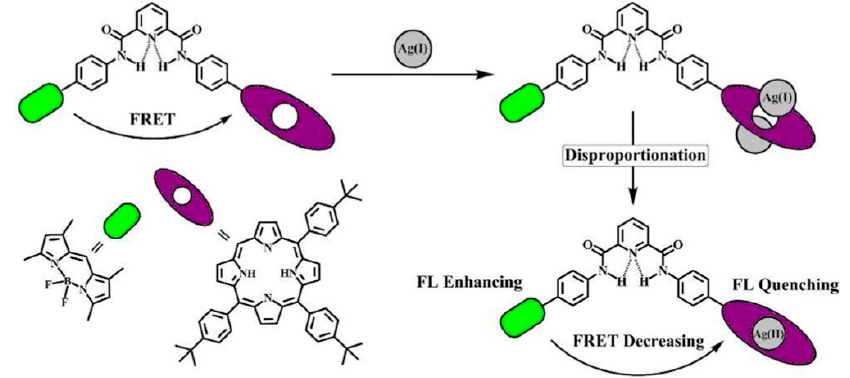
Figure 7. Schematic diagram of BODIPY–porphyrin dyad for the detection of metal ions by FRET. Reproduced from ref [30,91].